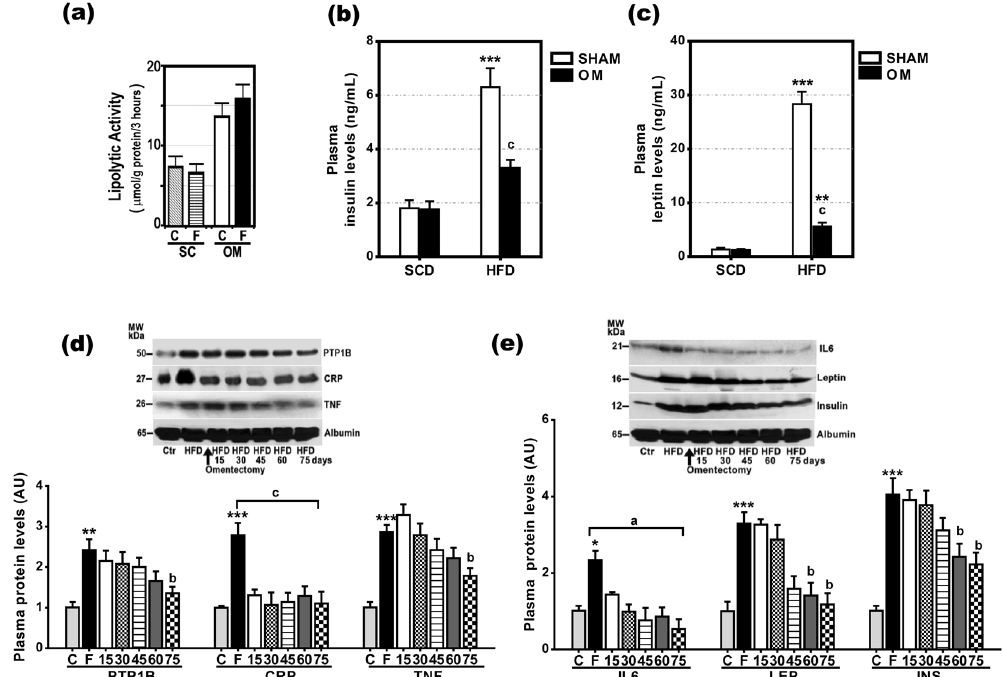
Figure 7. Evolution of plasma PTP1B, CRP, TNF- α , IL-6, leptin, and insulin levels after omentectomy and lipolytic activity of subcutaneous and omental fat. ( a ) Lipolytic activity of subcutaneous (SC) and omental (OM) fat in SCD- (C)- and HFD -fed (F) rats. ( b , c ) Plasma insulin ( b ) and leptin ( c ) levels in SCD, SCD/O, HFD and HFD/O-rats. ** p < 0.01; *** p < 0.001 effect of diet; ( c ), p < 0.001 effect of surgery. ( d , e ) Evolution of plasma PTP1B, CRP, TNF-, IL6, LEP, INS, and albumin levels after omentectomy at the age of 14 weeks in rats on a HFD. Results are given as mean ± S.D. Protein expression in rats on a standard chow diet was assumed to be 1. ** p < 0.01 *** p < 0.001 vs . SCD-rats. a p < 0.05; b p < 0.01; c p < 0.001 vs .